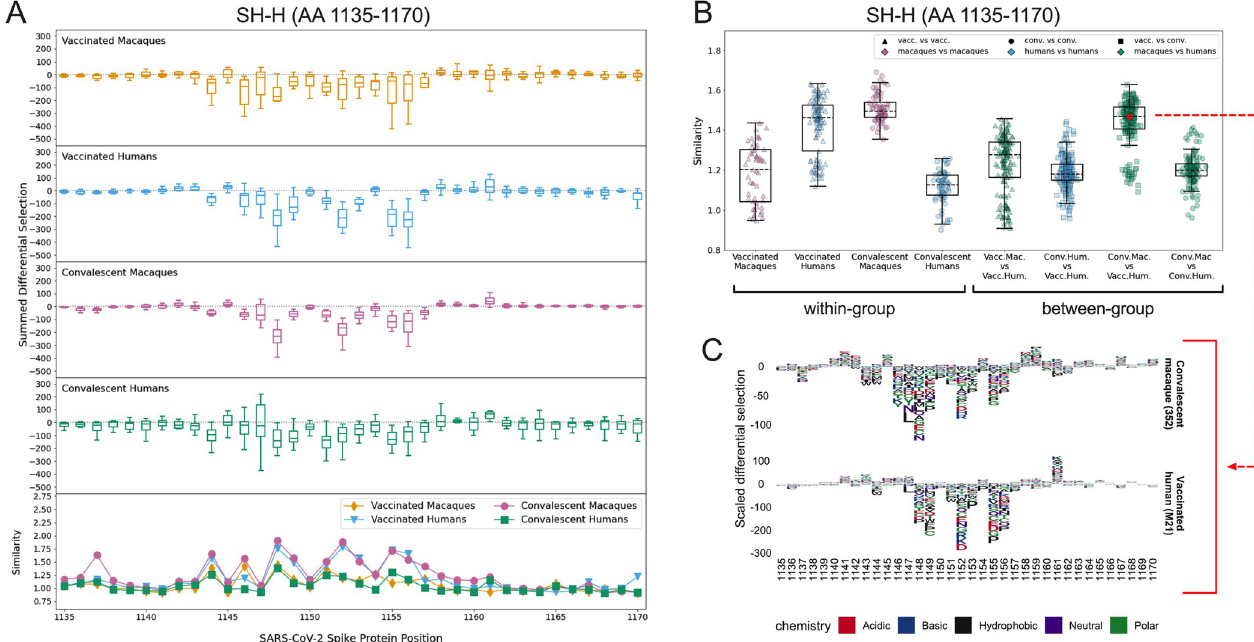
Fig 5. Comparison of escape profiles in the stem helix-HR2 region (SH-H). (A) and (B) Data are shown as described in Fig 3. (C) Logo plots for participant 352 (a convalescent macaque) and M21 (a vaccinated human) showing the effect of specific mutations on antibody binding at each site. The comparison between these samples had an escape similarity score closest to the median value for all pairwise convalescent macaque vs. vaccinated human comparisons and thus can be considered representative of the similarity between these groups. The 352 –M21 comparison is shown in red on (B).